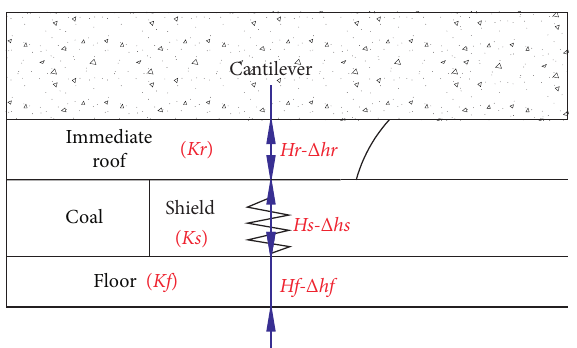
Figure 4: Sinkage model of